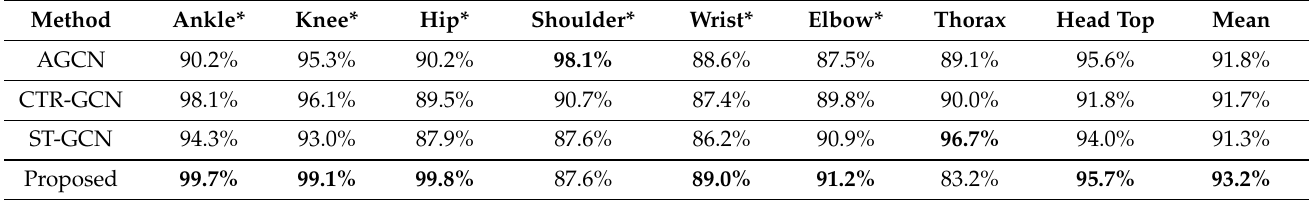
Table 4. PCK of different methods on the FSD dataset.